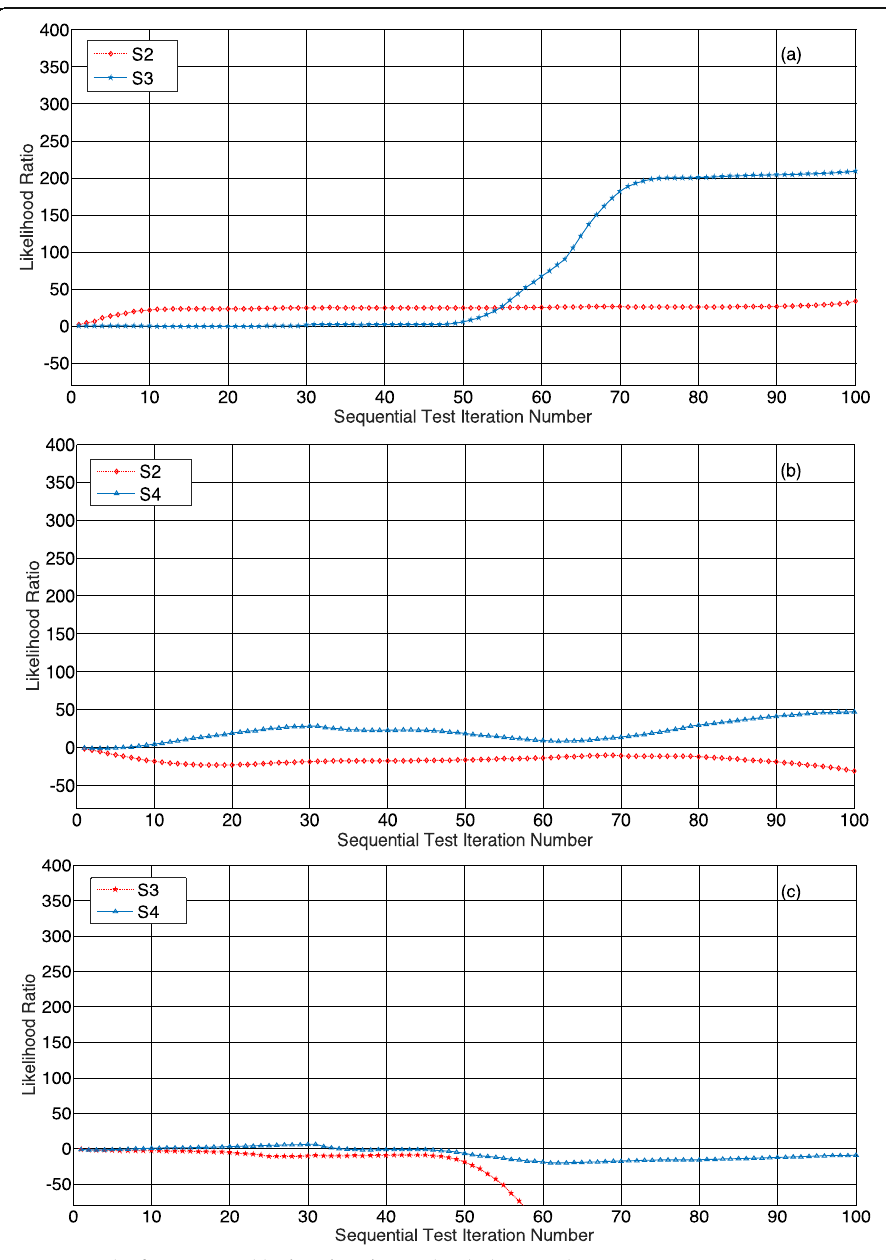
Fig. 24 Result of SPRT in variables λ 2, 3 , λ 2, 4 , λ 3, 4 with calculation